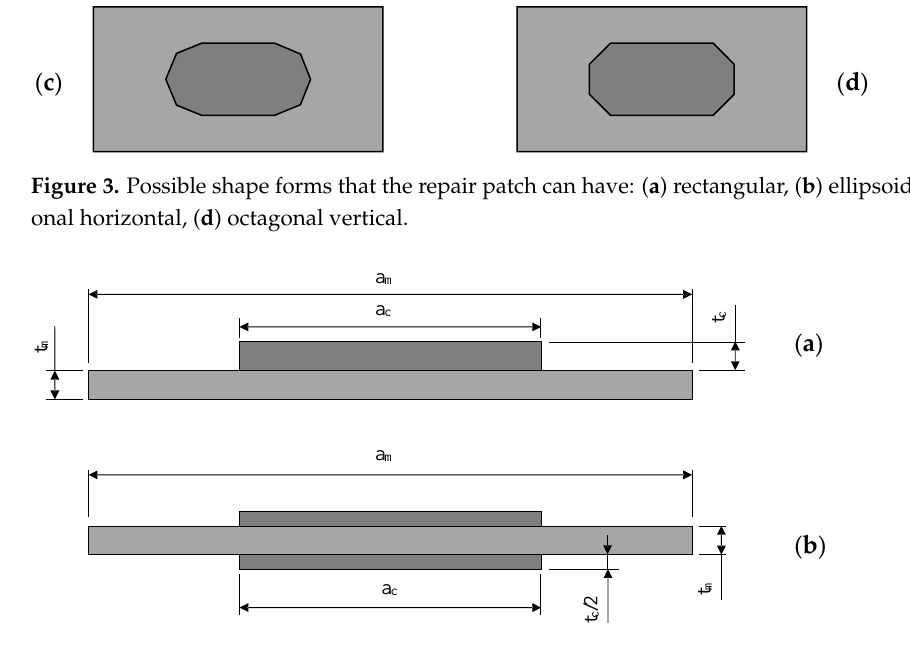
Figure 4. Possible patch configurations: ( a ) one-sided application (single strap joint) and ( b ) two- sided application (double strap joint).